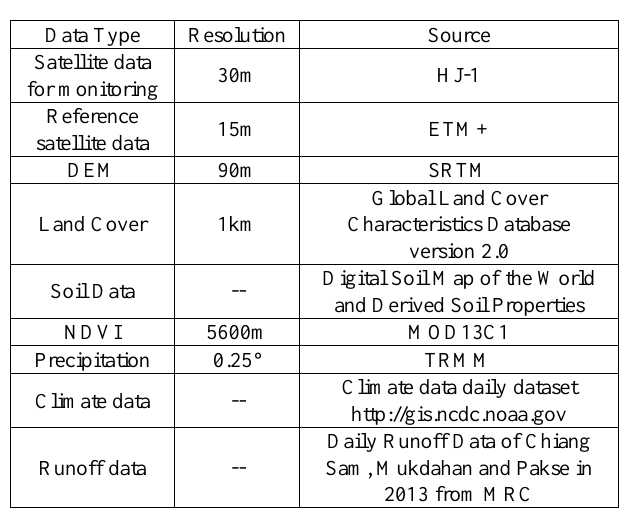
Table.1 Data source